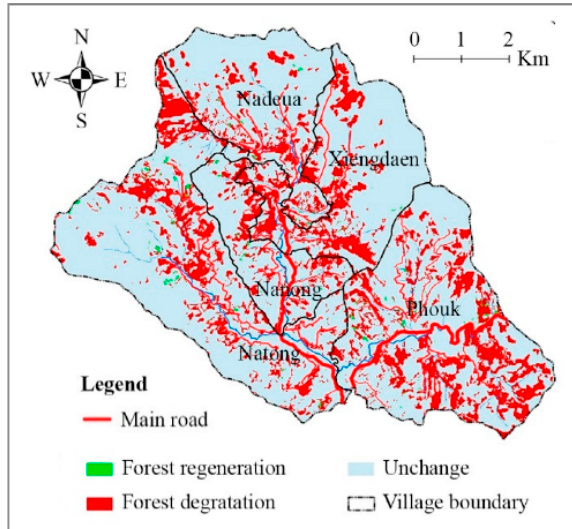
Figure 3. Forest changes 2003–2015.